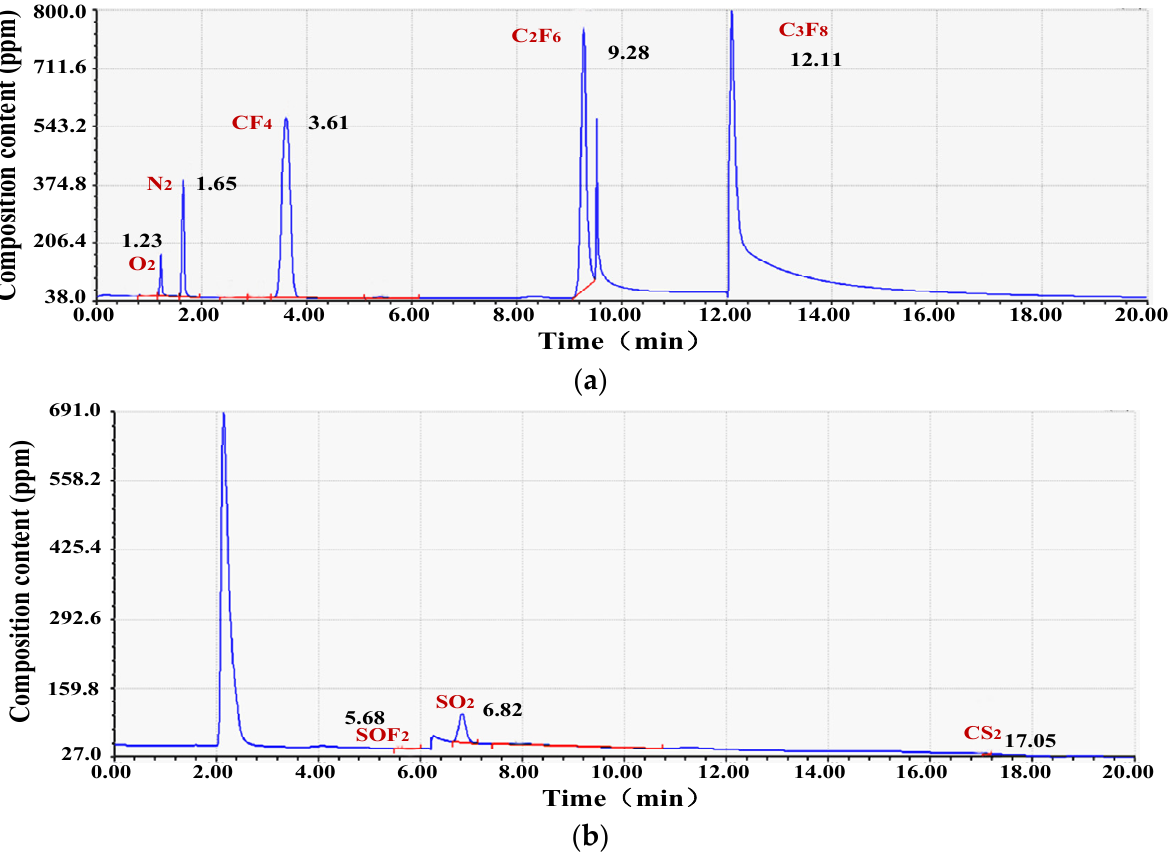
Figure 3. Test results of gas in the test switch. ( a ) PDD1 chromatogram. ( b ) PDD2 chromatogram.